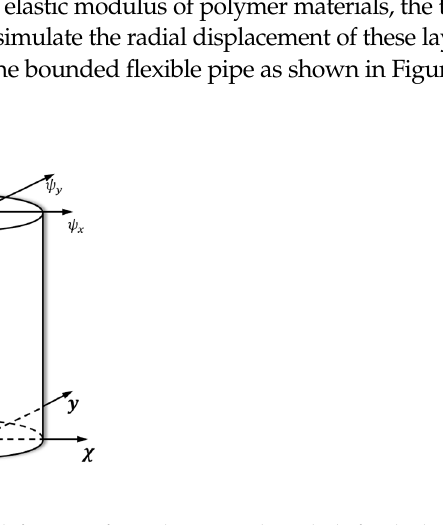
Figure 2. The definition of coordinates and symbols for the bounded flexible pipe: ( a ) global; ( b ) local.